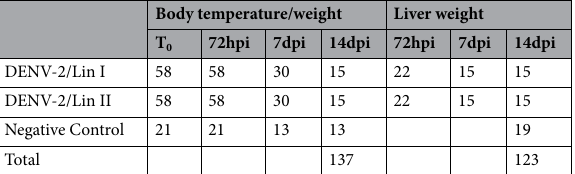
Body temperature/weight